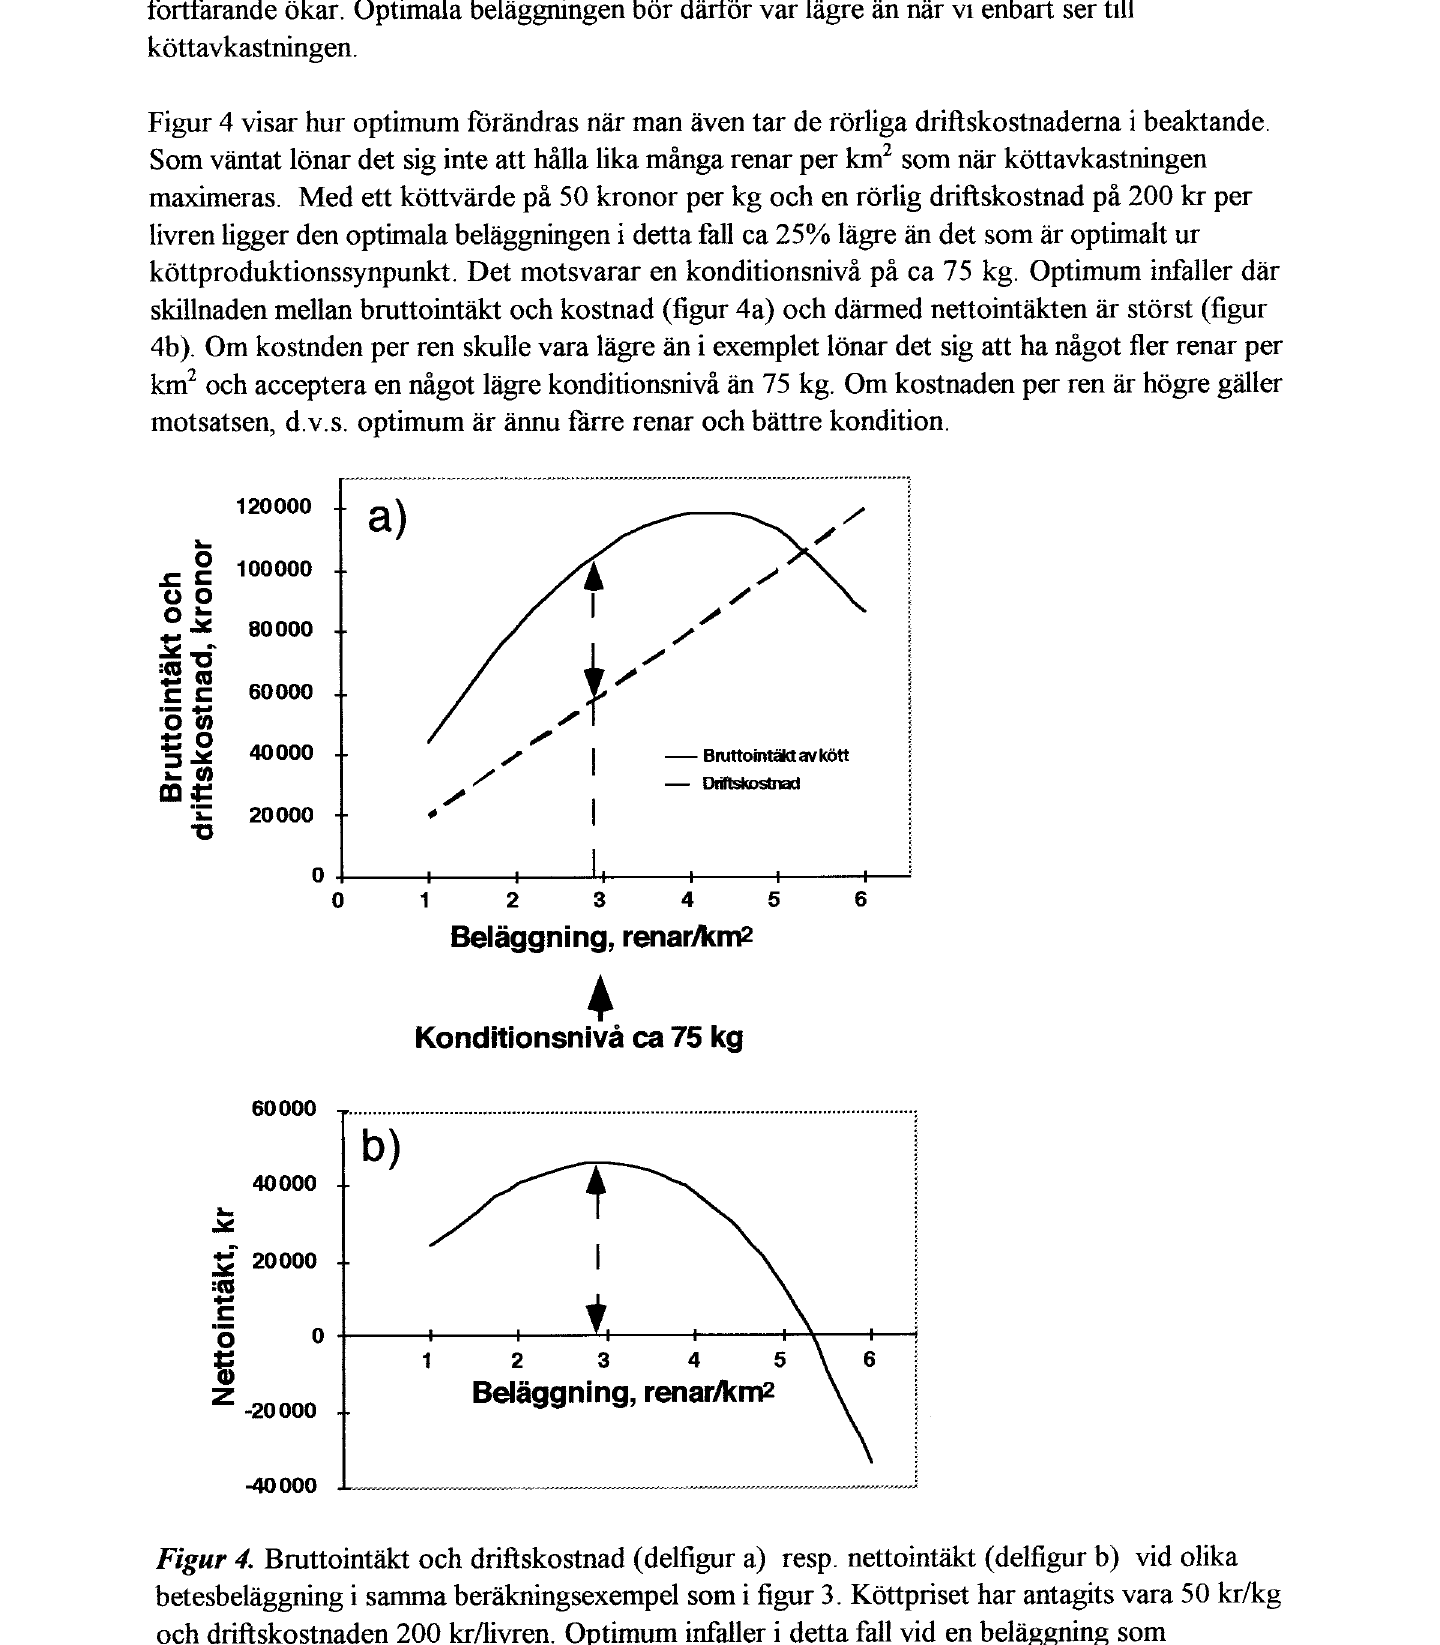
Figur 4. Bruttointåkt och driftskostnad (delfigur a) resp. nettointåkt (delfigur b) vid olika betesbelåggning i samma beråkningsexempel som i figur 3. Kottpriset har antagits vara 50 kr/kg och driftskostnaden 200 kr/livren. Optimum infaller i detta fall vid en belåggning som motsvarar ca 75 kg i